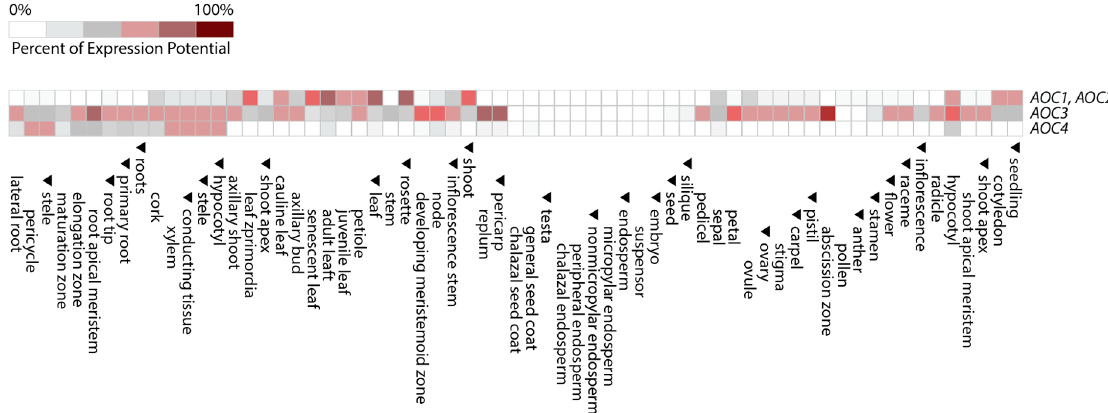
Figure 4. Tissue and development-specific expression of AOC1 - 4 from Arabidopsis thaliana . The Genevestigator database [74] was used to contrast the specific expression pattern of AOC1-4 . The patterns reveal a clear expression of AOC1 and 2 in areal tissues, while being absent in roots and only very little expressed in flowers. AOC4 is seemingly restricted to root tissues, whereas AOC3 expression is detected at different levels in all tissues.